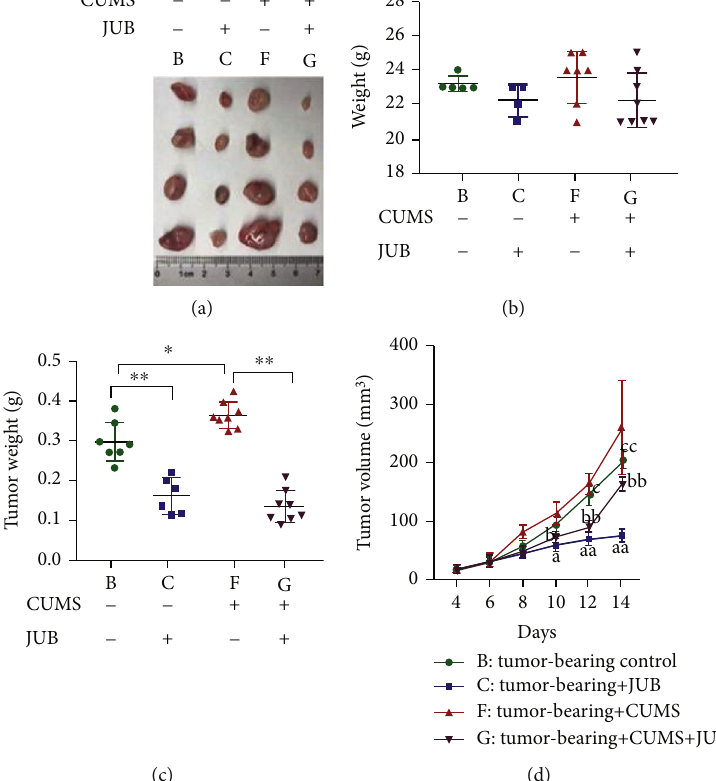
Figure 4: E ff ect of JUB and CUMS on tumor progression. (a) Observation of tumor tissues. (b) Tumor weight in di ff erent groups. (c) Mice body weight. (d) Volume of tumor. Data are mean ± SD ( n = 8/group ). ∗ P < 0 : 05and ∗∗ P < 0 : 01 a P < 0 : 05 and aa P < 0 : 01 : tumor-bearing control vs. tumor-bearing +JUB; b P < 0 : 05 and bb P < 0 : 01 : tumor-bearing +CUMS vs. tumor-bearing+ CUMS+JUB; c P < 0 : 05 and cc P < 0 : 01 : tumor-bearing control vs. tumor-bearing+